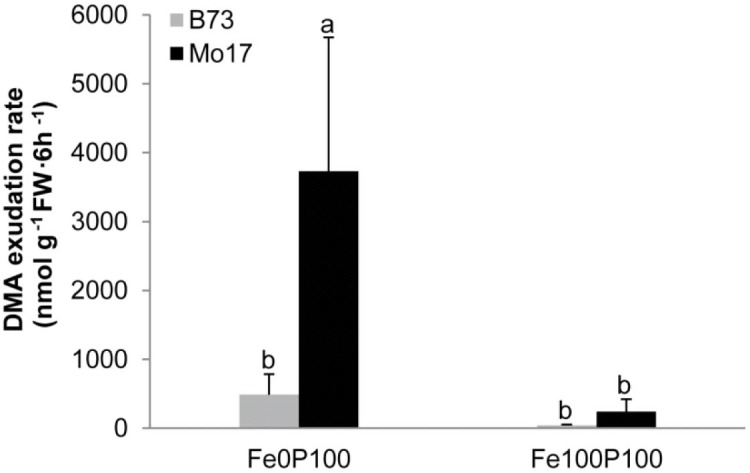
Iron deficiency-induced phytosiderophore release by B73 and Mo17. Plants were grown in nutrient solution containing 100 μM P and 100 μM Fe (Fe100P100) or no Fe (Fe0P100). The whole system was cultivated under axenic conditions. Root exudates were collected three times over a period of 6 h and pooled prior to HPLC analysis of deoxy-mugineic acid (DMA). Bars indicate mean values ± SD, n = 5. Different letters denote significant differences at p < 0.05.